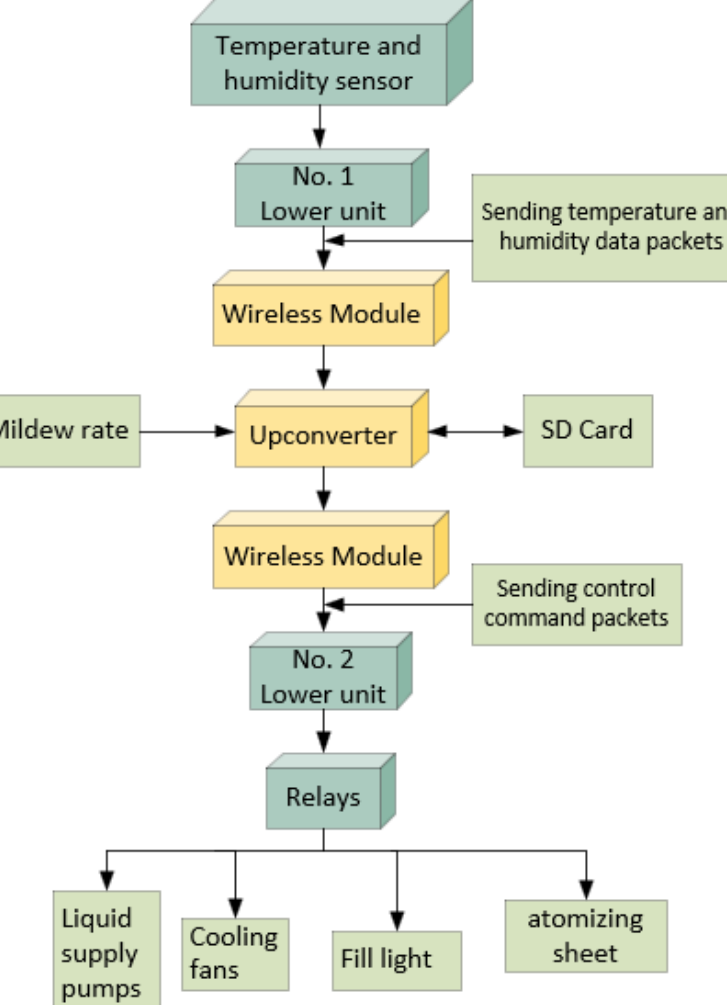
Figure 1. Control system architecture diagram.